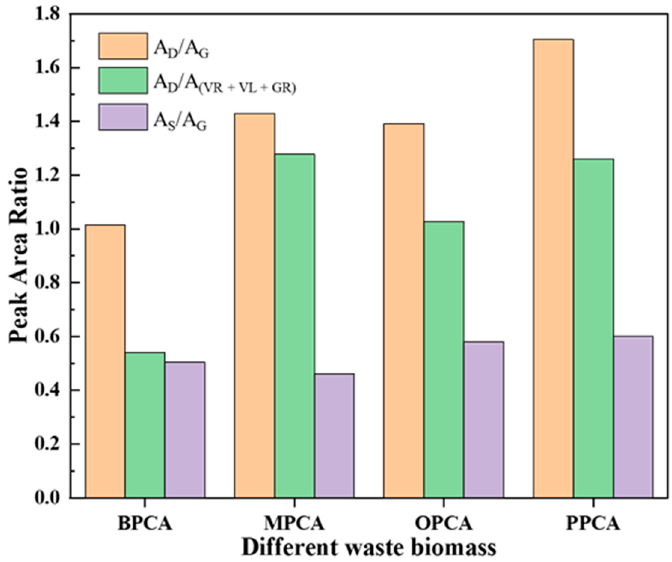
Figure 5. Analysis of Raman band area ratios of CAs prepared from different waste biomasses.